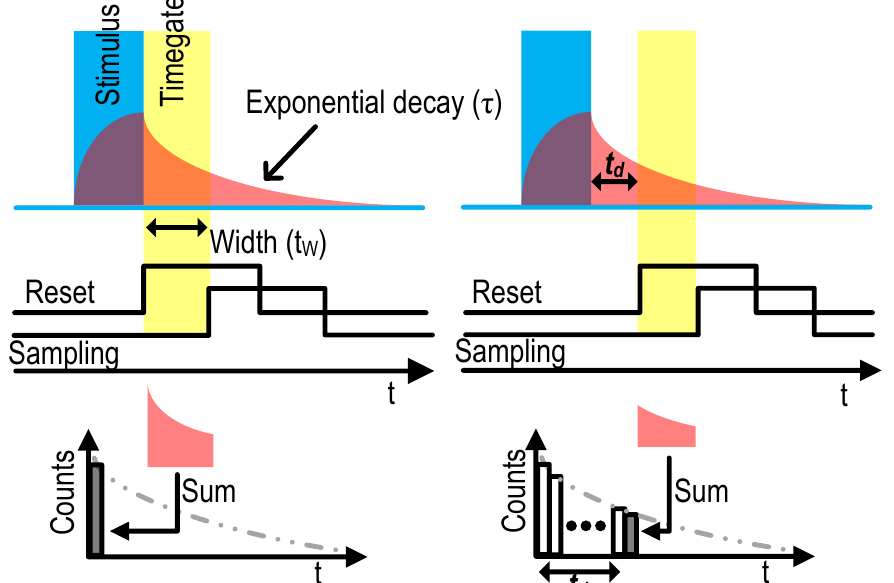
Figure 5. Statistical sampling with detection window width ( t W ), detection window shift ( t d ), lifetime ( τ ) for lifetime estimation. Note that the proposed system is able to achieve t W = t d ≥ 72 ps whereas, t W ∼ 2.4 × τ is used in this